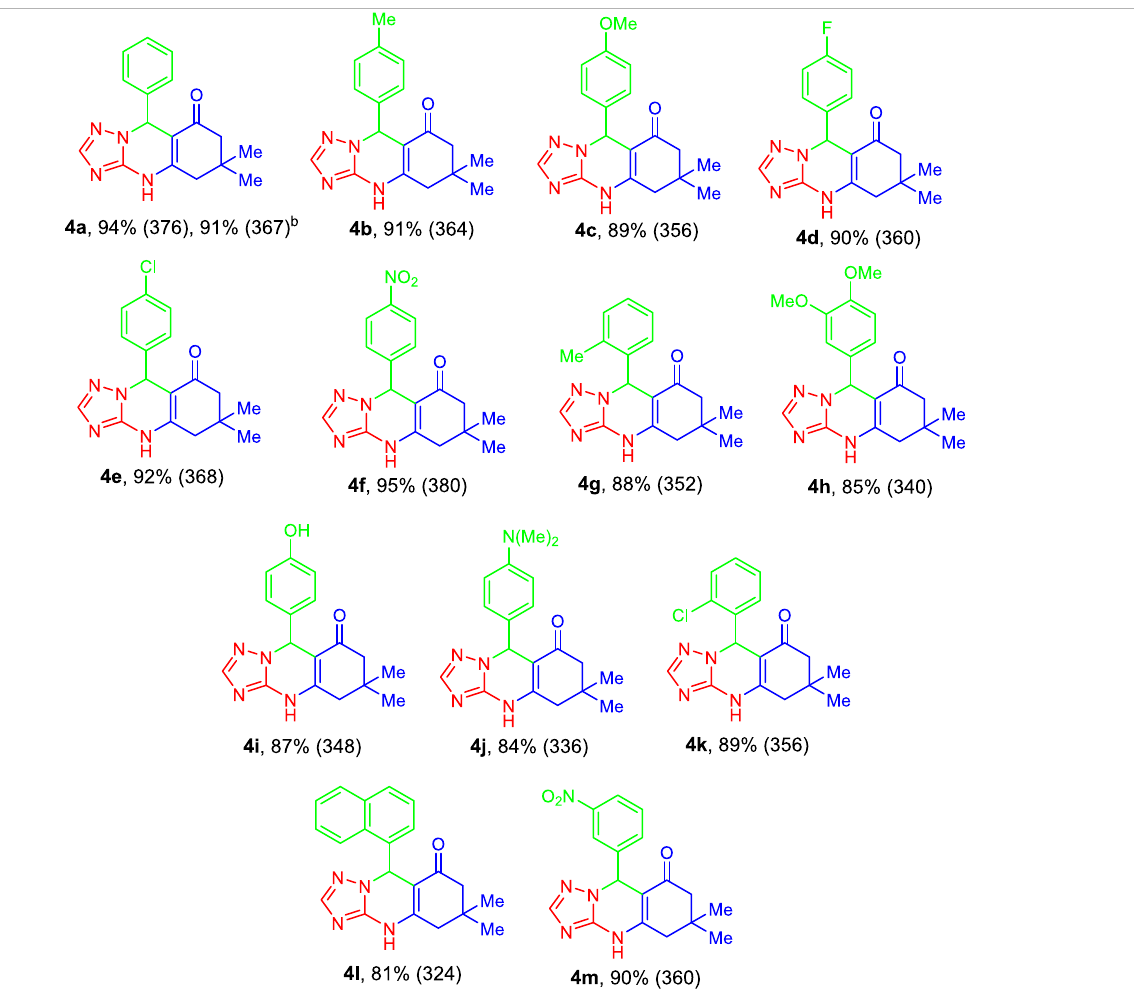
TABLE 2 | Synthesis of a variety of quinazolinones under optimized conditions ab